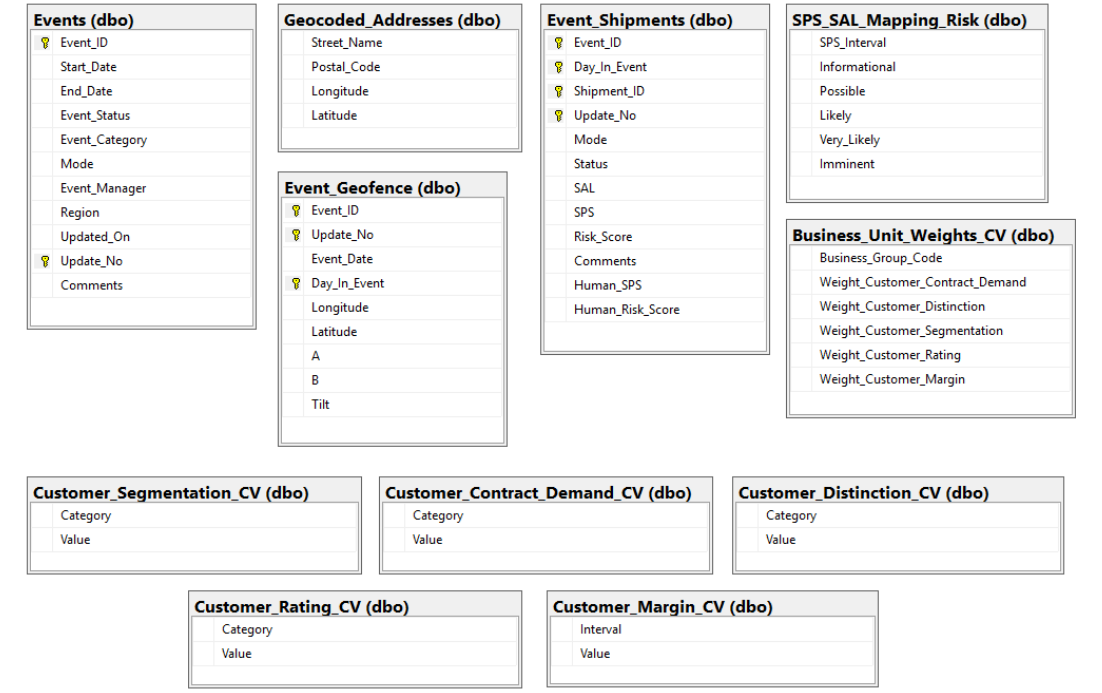
Figure 6. The 11 tables used in the RA